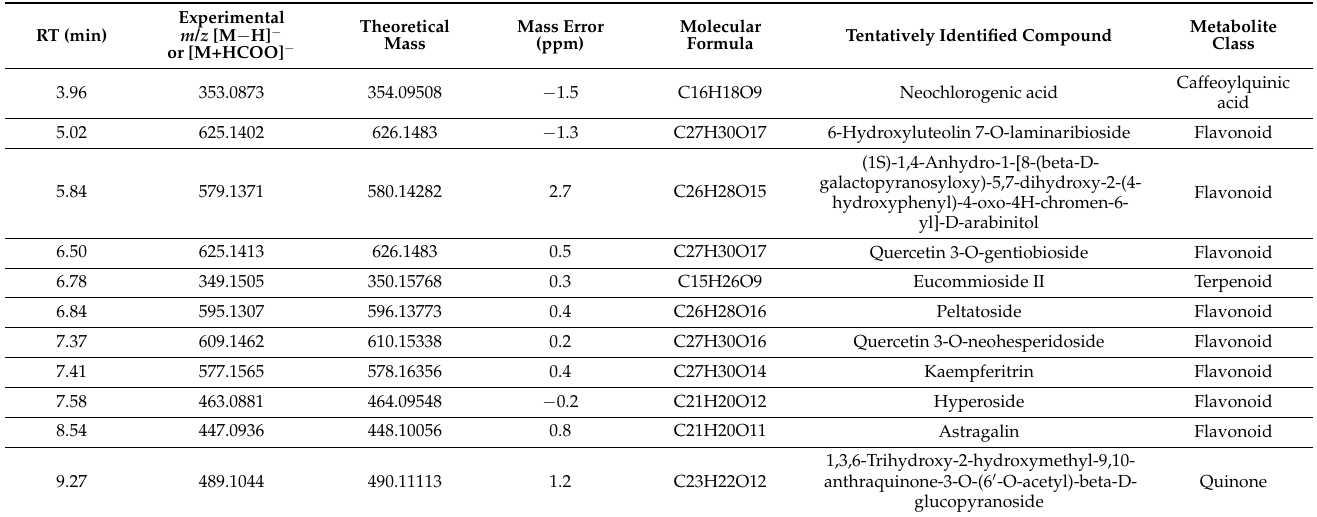
Metabolite Class